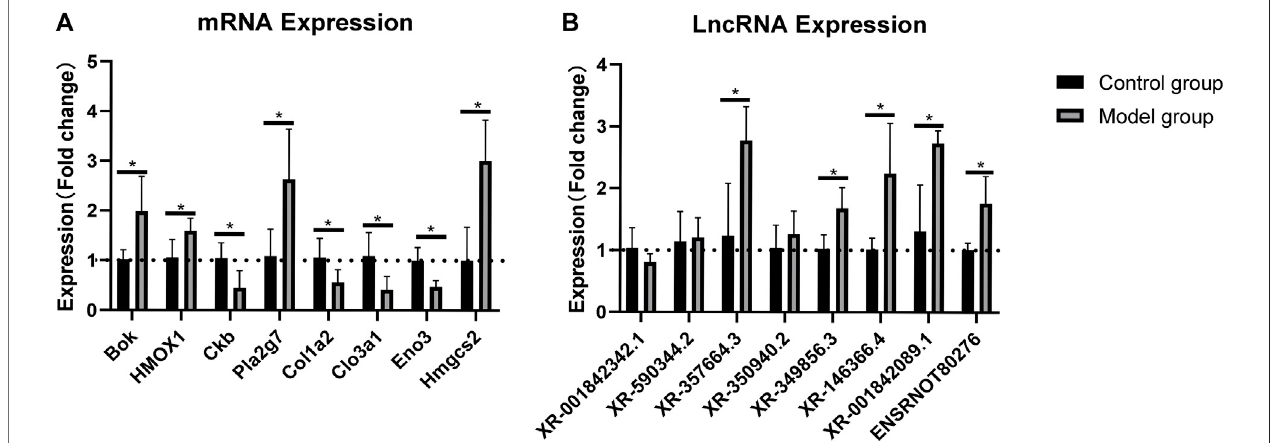
FIGURE 3 | Validation of lncRNAs and mRNAs by RT-qPCR analysis. Relative expression of each lncRNA and mRNA was normalized to that of GAPDH . Data are represented as mean ± SEM, * p <